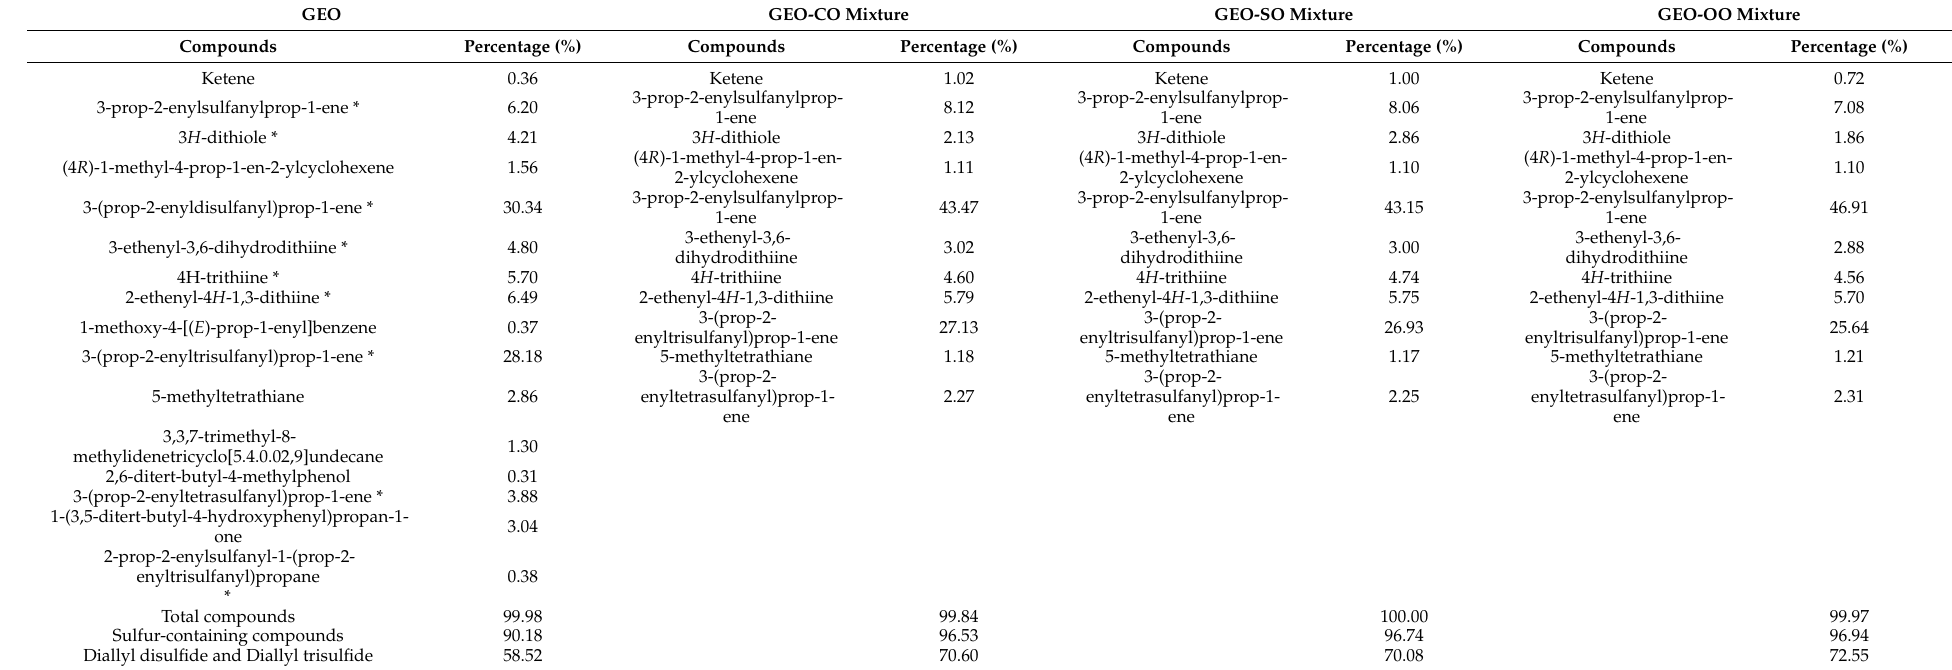
Table 1. Volatile compounds of GEO and GEO-VO